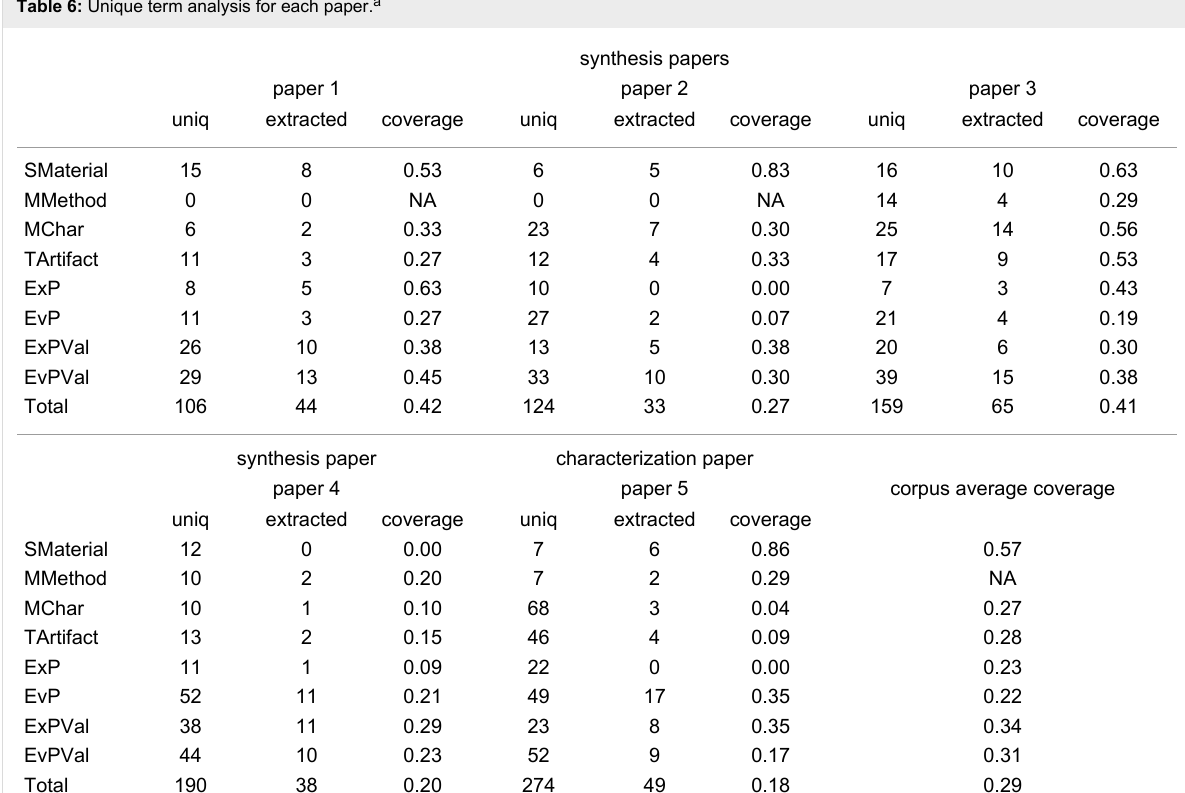
Table 6: Unique term analysis for each paper. a